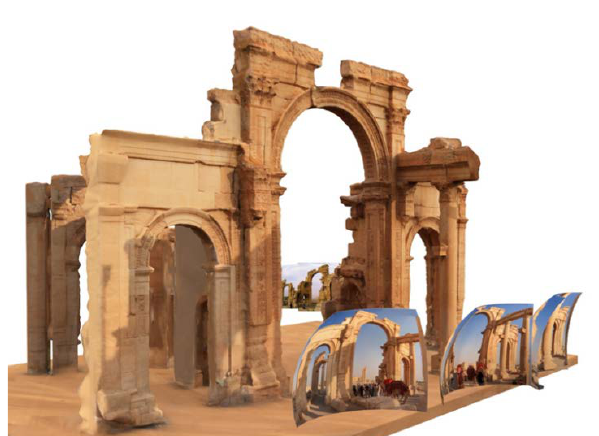
Figure 9. The final model of the Arch of Triumph and the used